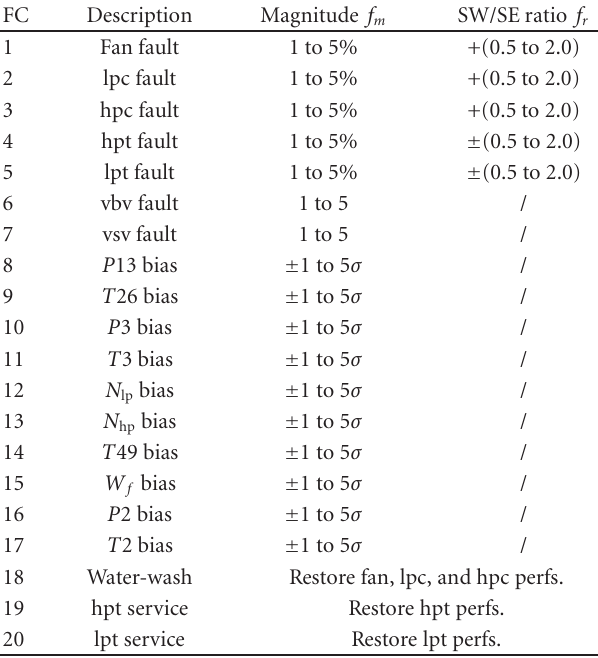
Table 3: List of considered abrupt events—FC stands for fault code.